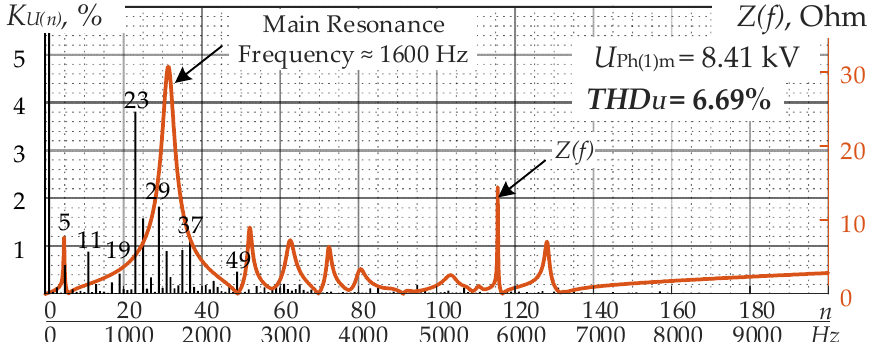
Figure 26. The frequency response and the spectral analysis of voltage in the sections of the MSDS 10 kV distribution device.